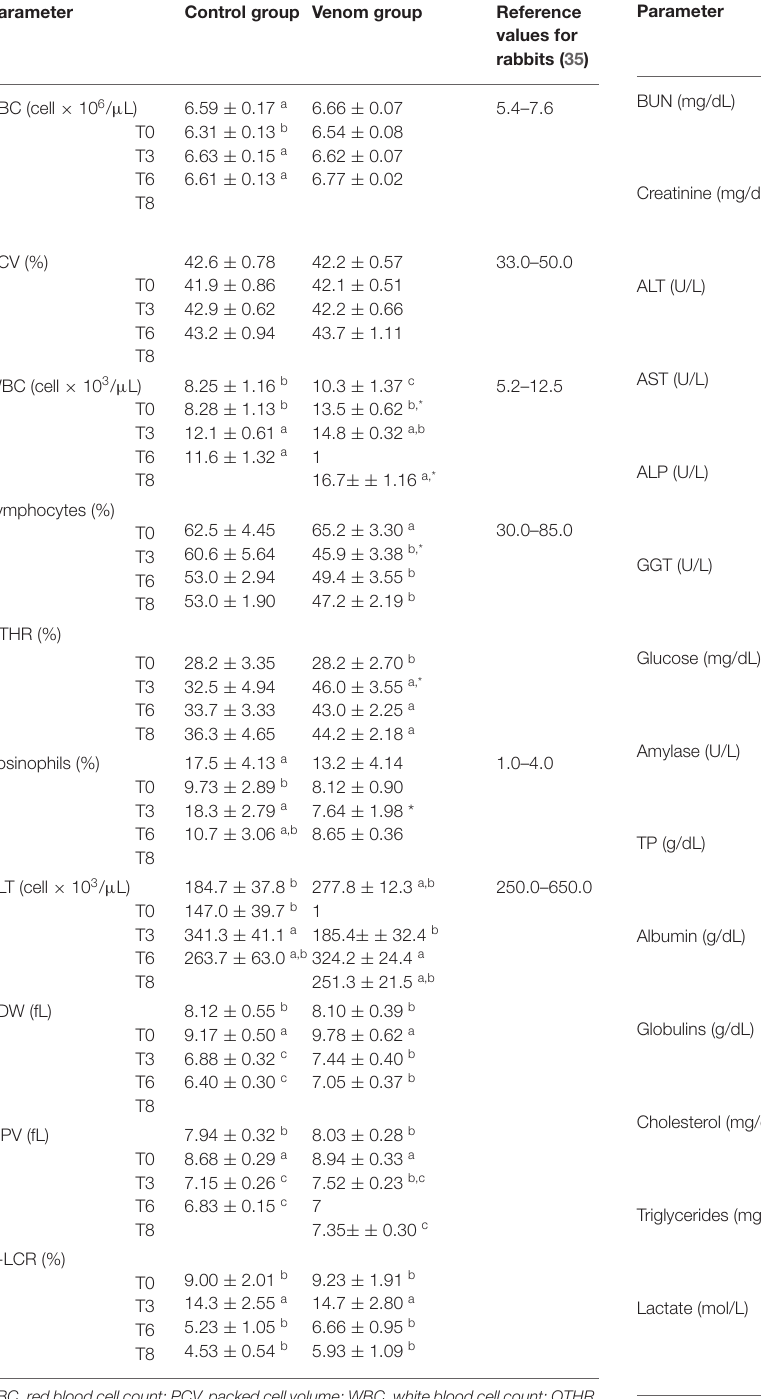
TABLE 2 | Hematological examination of rabbits that underwent immunization protocols with Loxosceles venom + Montanide (VG) and rabbits that received Montanide + phosphate-buffer saline (PBS) [Control group (CG)].